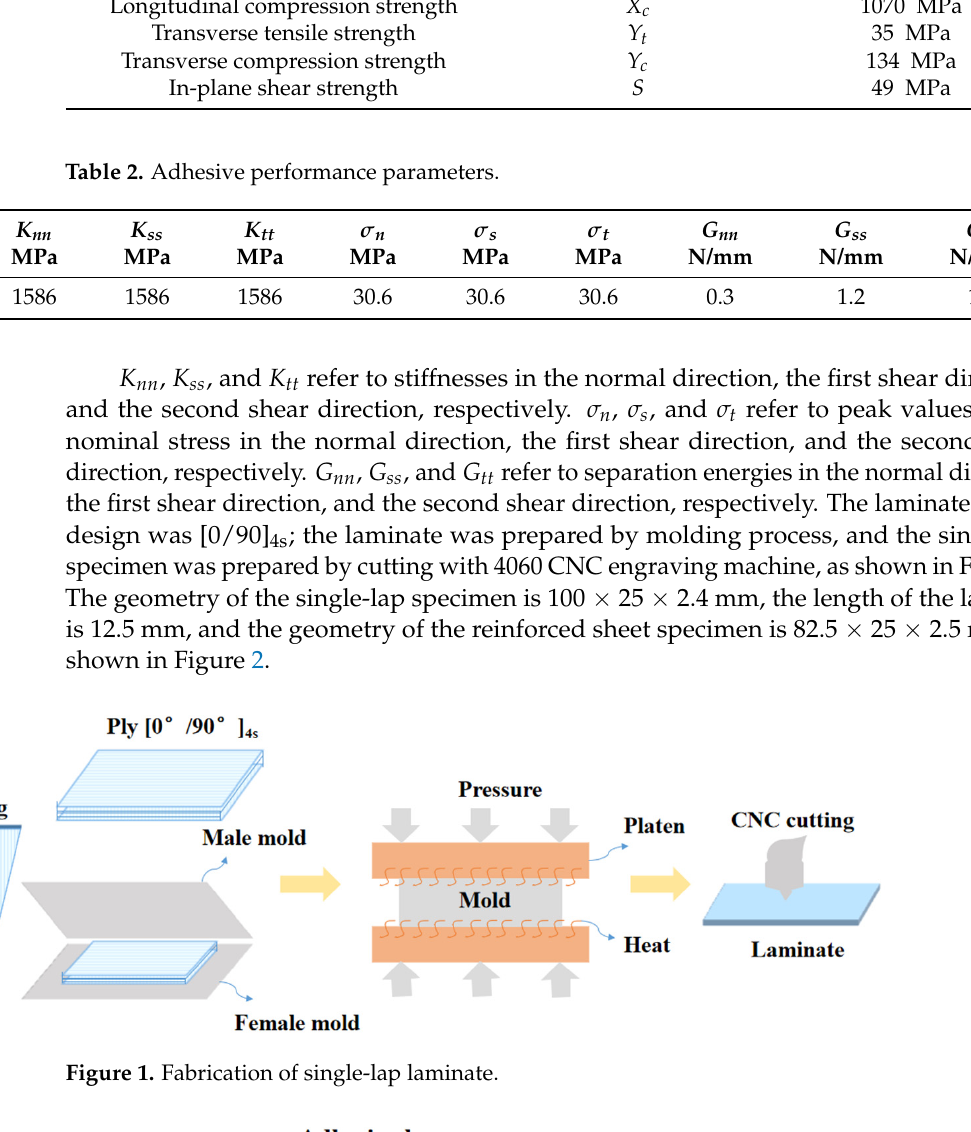
Table 1. ZPNPREG ® 2551/150/37 parameters.